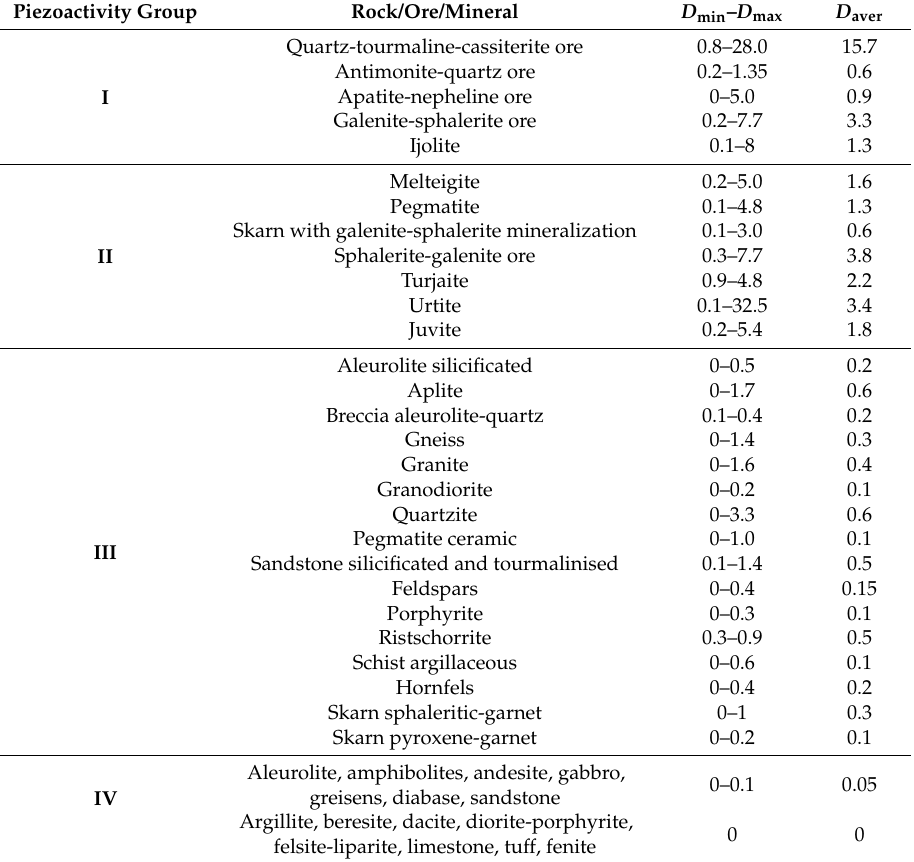
Table 1. Classification of some rocks, ores, and minerals by their piezoactivity d , 10 − 14 Coulomb/Newton (after [14,30], with modifications).